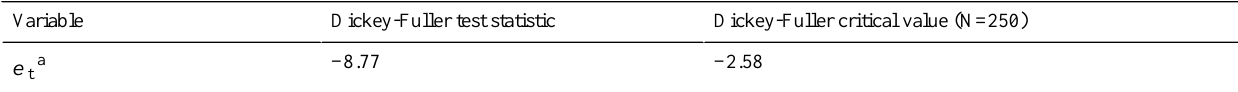
Table 2. Dickey-Fuller test for the residual sequence.